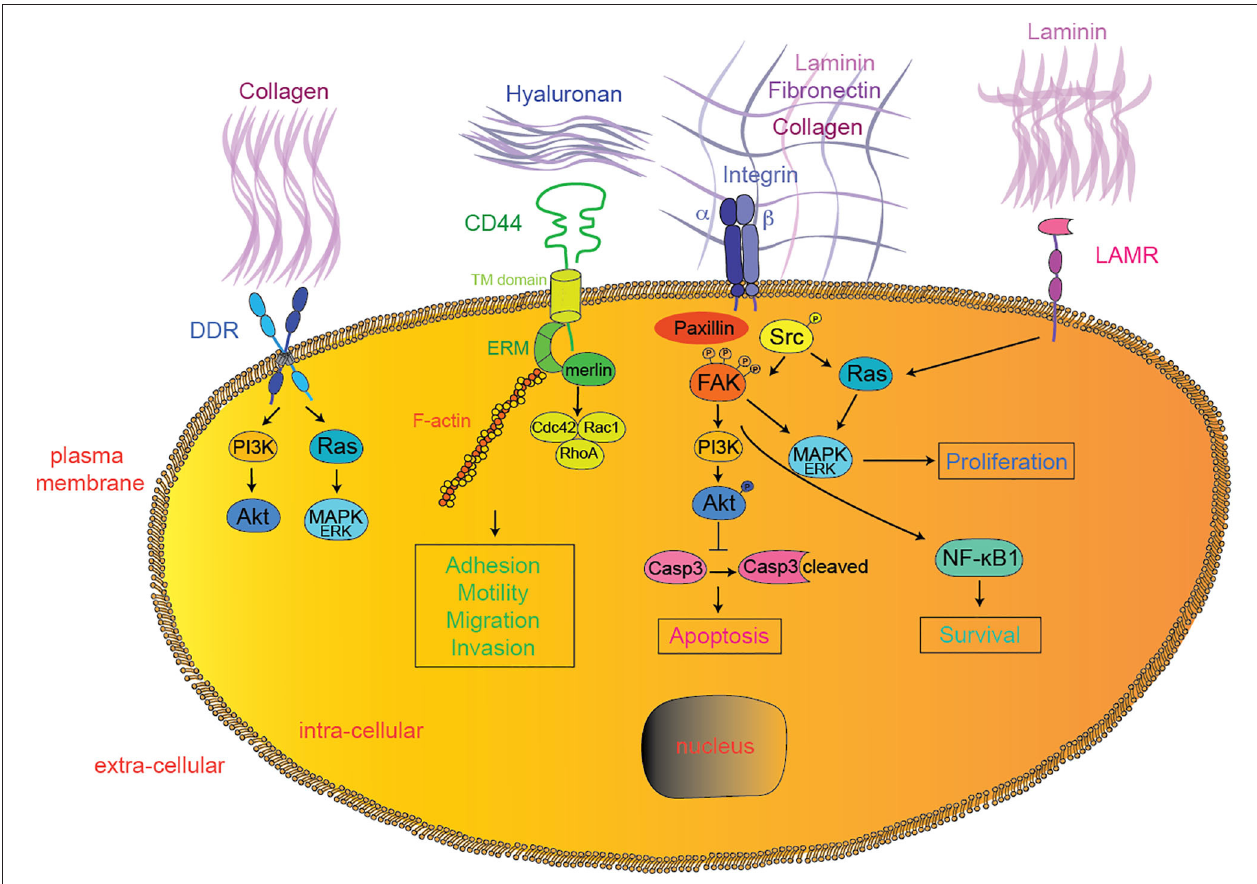
FIGURE 1 | Extracellular matrix—tumor cell interactions. In addition to integrins, DDR, CD44, LAMRs, FAK, and SFK represent emerging therapeutic targets currently tested in clinical trials for solid tumors. Downstream effectors interactions were simplified for clarity reasons. DDR, discoidin domain receptor; LAMR, 36/67 kDa laminin receptors; FAK, focal adhesion kinase; PI3K, phosphoinositide-3-kinase; MAPK, mitogen-activated protein kinases; Casp3, caspase 3; NF- κ B1, nuclear factor-kappa